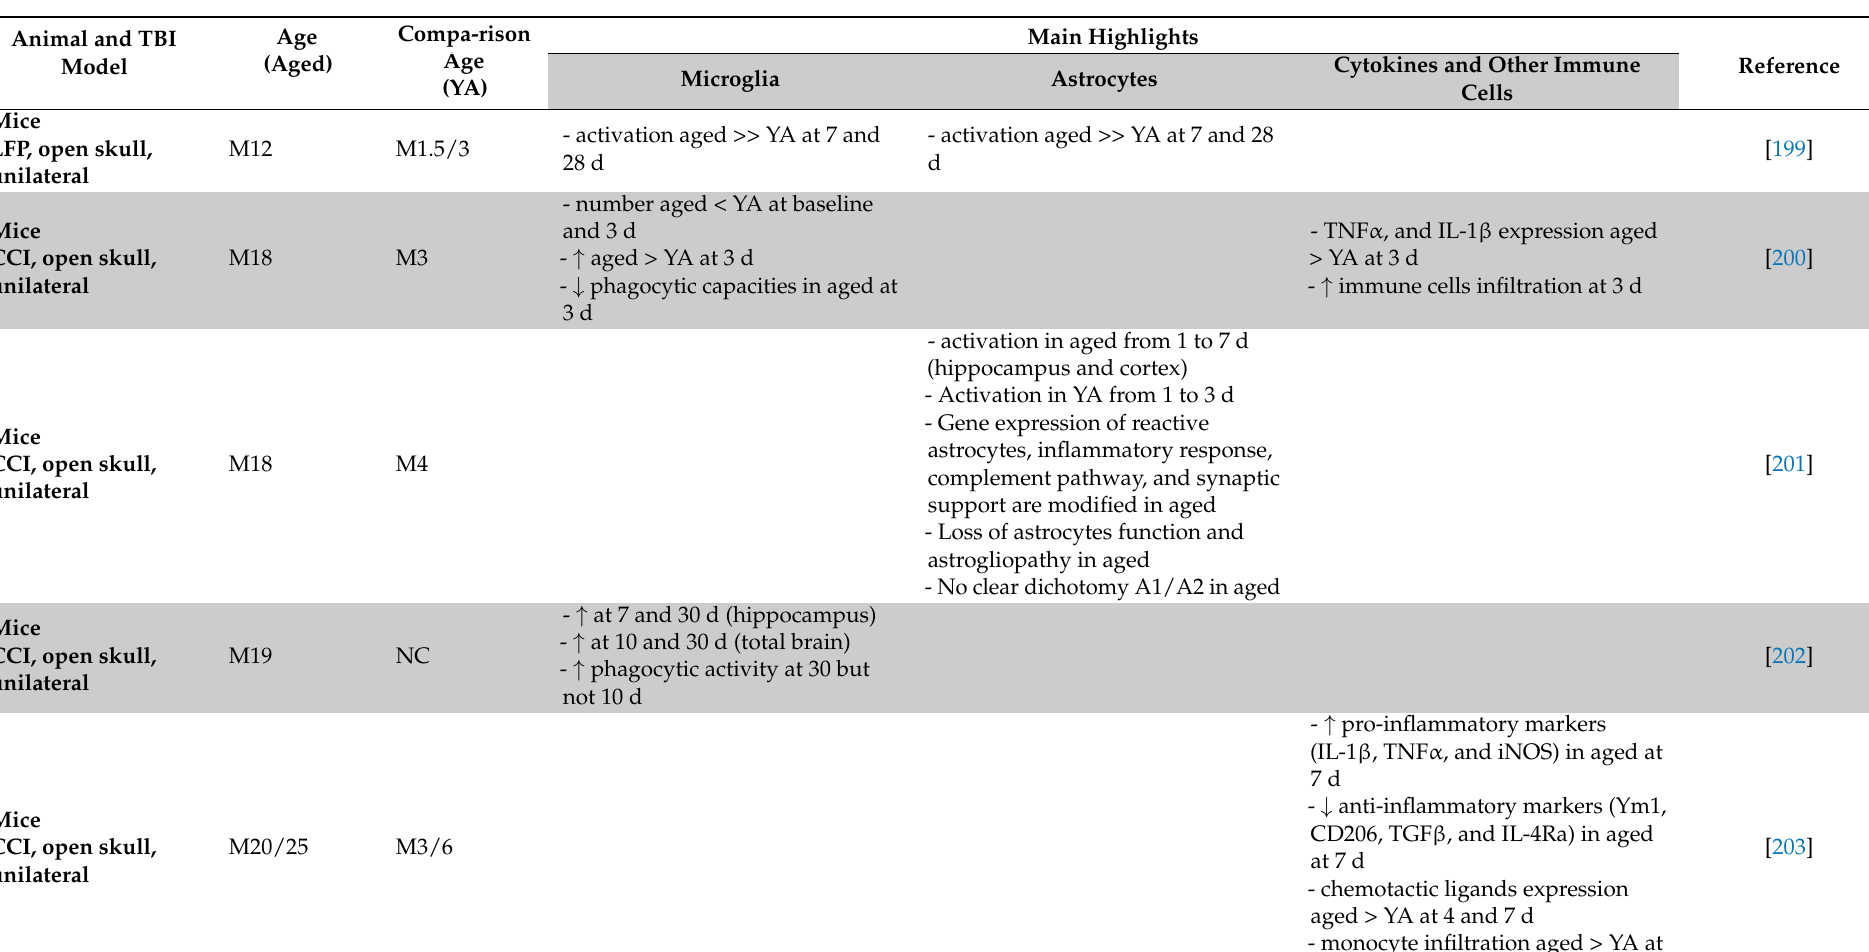
Table 4. Post-traumatic inflammatory consequences on aged animals. Abbreviations: ↑ : increase; ↓ : decrease; CCI: controlled cortical impact; CD: cluster of differentiation; CX3CL1: chemokine (C-X3-C motif) ligand 1; d: days post-injury; h: hours post-injury; IFN γ : interferon γ ; IL: interleukin; iNOS: inducible nitric oxide synthase; LFP: lateral fluid percussion; M: post-natal months;